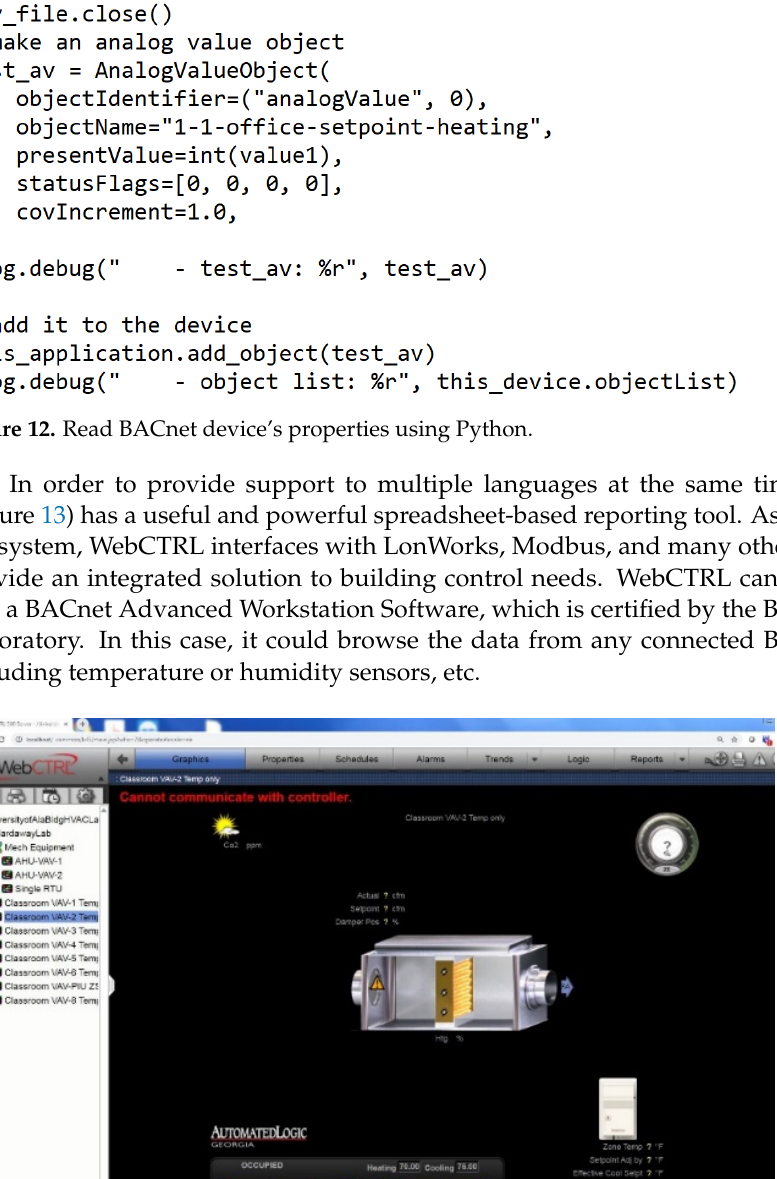
Figure 14. Communication configurations in WebCTRL through UDP. Figure 15 shows that UDP establishes the communication between the data server and WebCTRL. In this example, the reading data displayed in the YABE browser based on BACnet protocol witnessed successful communication. Figure 15. Communication between WebCTRL and our data server.